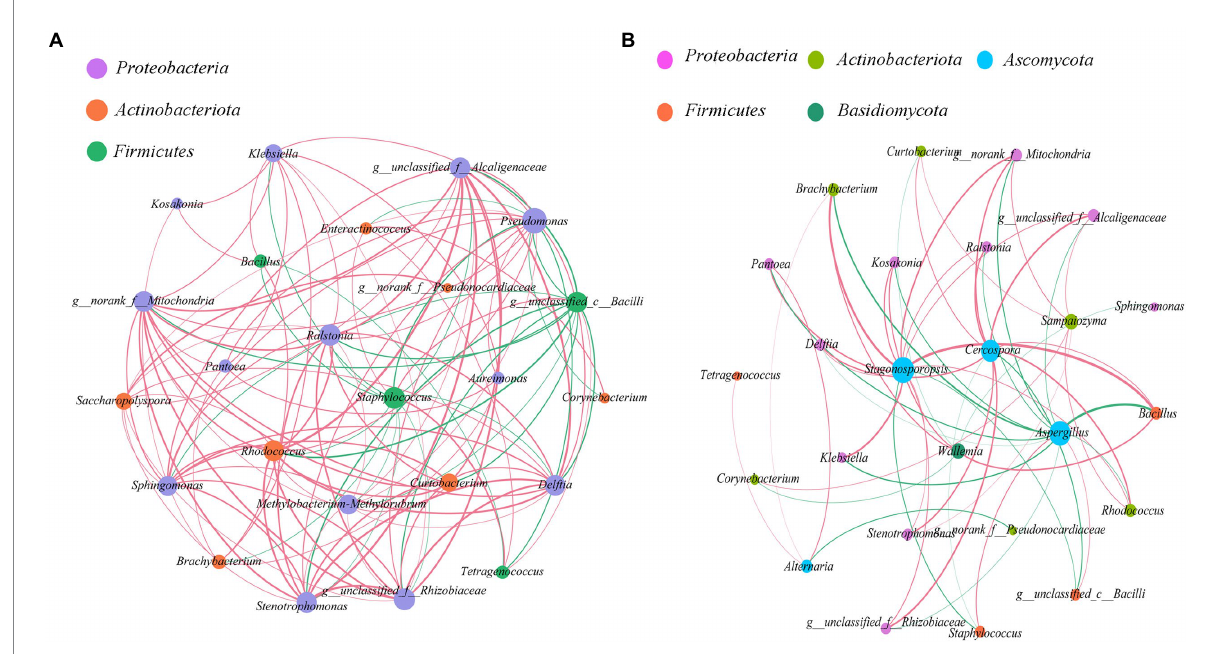
FIGURE 6 Co-occurrence and antagonism relationship among microbes within the cigar samples (| ρ | > 0.5, value of p <0.05). (A) bacterial-bacterial interaction; (B) bacterial-fungal interaction. Size of each node was proportional to the number of connections, the nodes were colored in groups, and the edge thickness was proportional to the absolute value of the spearman correlation